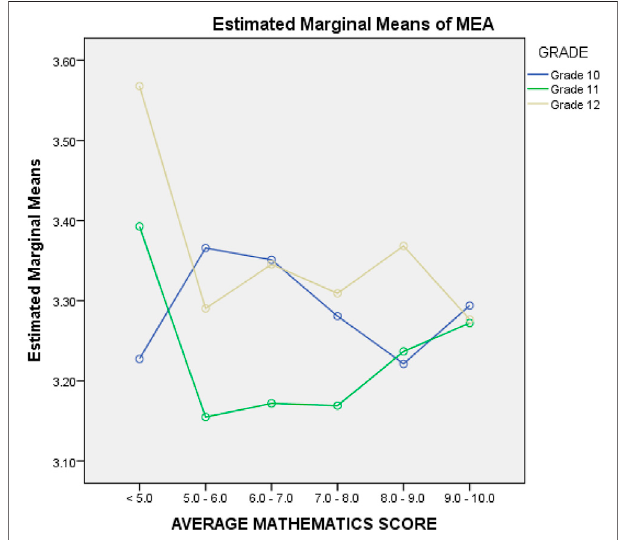
FIGURE 1 | Interaction plot.